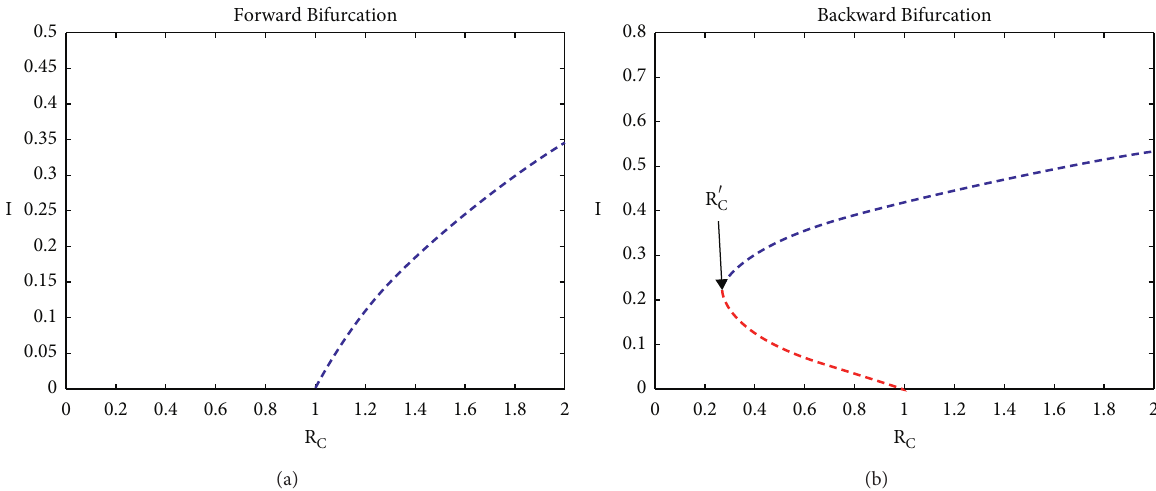
Figure 8: (a) Forward bifurcation and (b) backward bifurcation of endemic equilibria where the infected individuals are plotted as a function of R C . The blue dash line represents the stable equilibrium while the red dash line represents the unstable equilibrium. (a) shows forward bifurcation at the critical value R C � 1, and the parameter values used include μ � 0 . 18, δ � 0 . 12, κ � 0 . 03, β � 1 . 6, p � 0 . 12, c � 0 . 9, ϖ � 0 . 1, and 3 . 5 ≤Λ ≤ 5, while (b) represents backward bifurcation and parameters used are the same as in (a) except ϖ � 0 . 25.